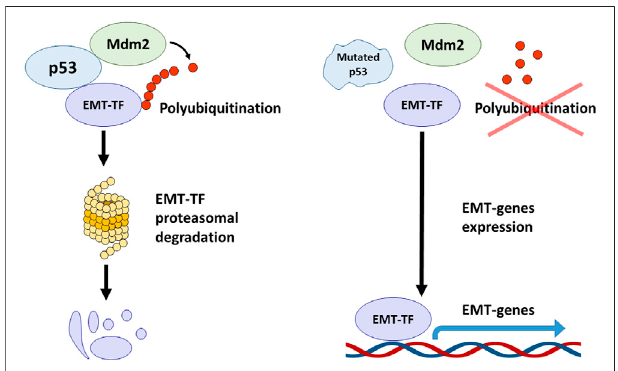
FIGURE 2 | The crosstalk between p53, Mdm2 and EMT transcription factors. The wild-type p53 forms the complex with Mdm2 and EMT-TFs mediating their polyubiquitination and proteasomal degradation. TP53 mutations abolish the ability of p53 to associate with EMT-TFs and to form the complex with Mdm2 that results in EMT-TFs stabilization and promotion of EMT